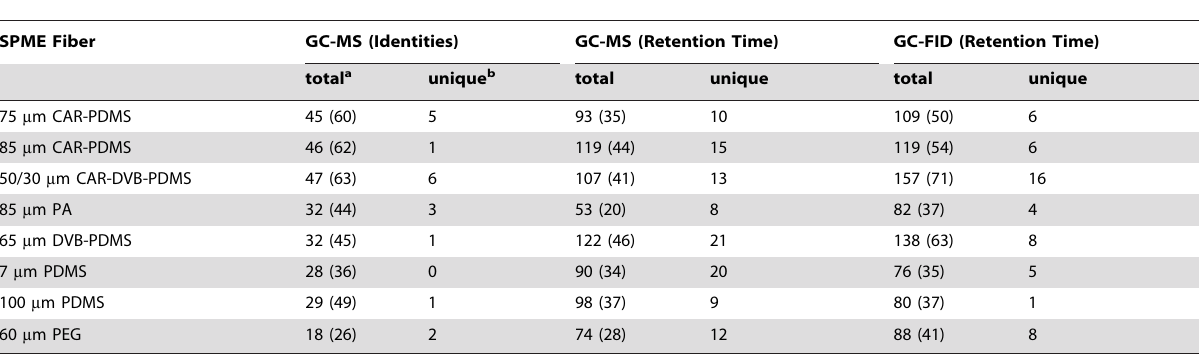
Table 2. Fiber-dependent extraction of